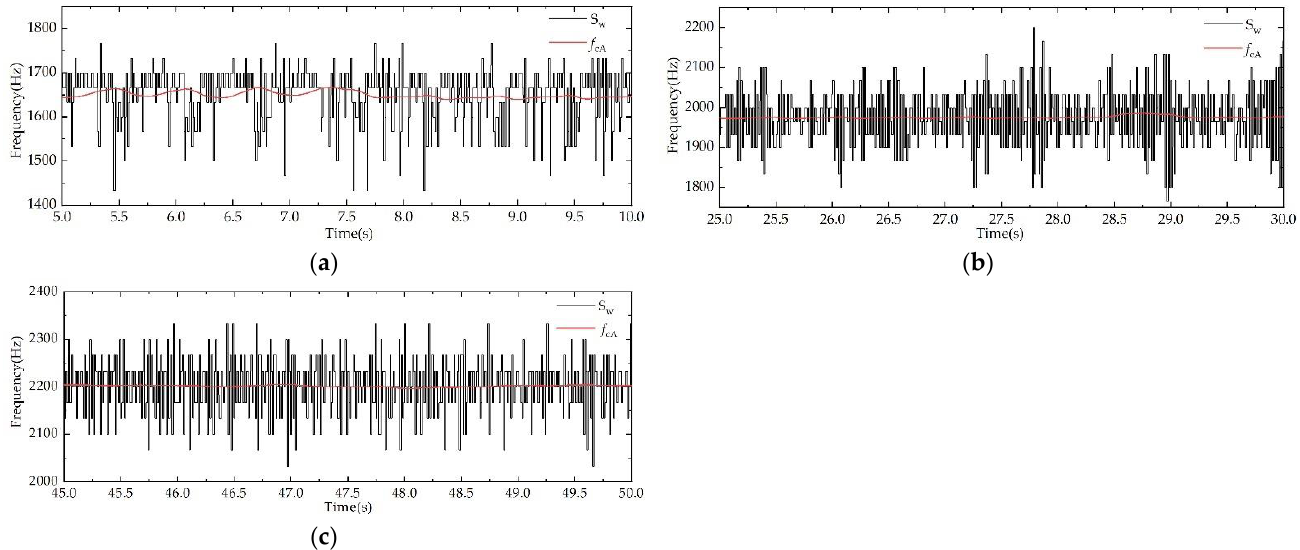
Figure 13. Switching frequency of FCS-MPC and calculated value of ASOGI center frequency: ( a ) At the speed of 5 r/min; ( b ) At the speed of 10 r/min; ( c ) At the speed of 15 r/min.